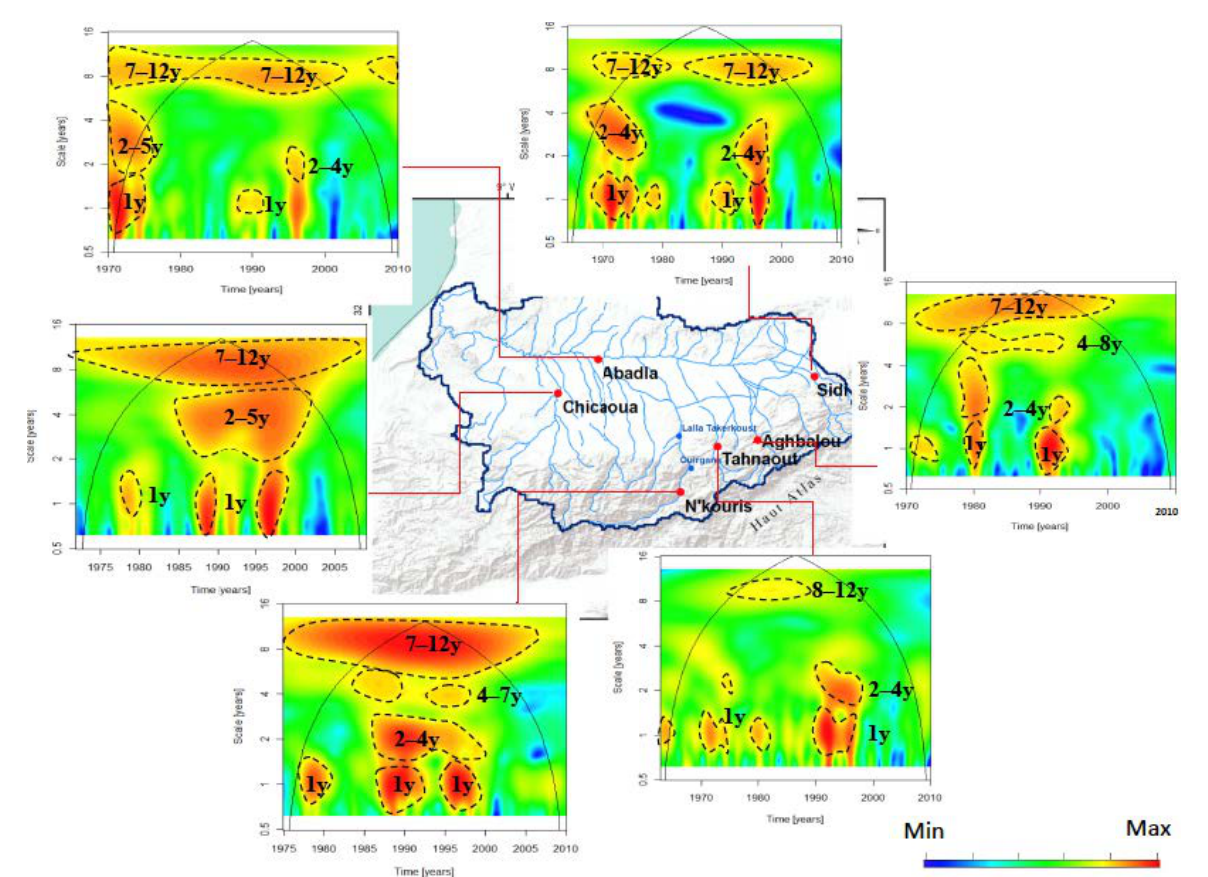
Figure 11. Study of hydrological variability in the Tensift basin. Table 3. The distribution of power for all modes of variability extracted from CWT analysis.